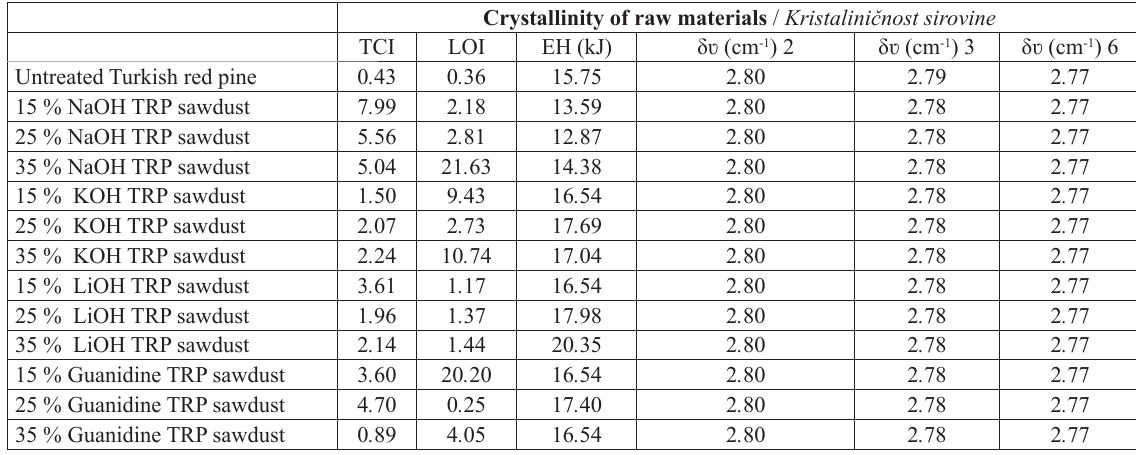
Table 1 Crystallinity of alkaline treated materials of Turkish red pine (TRP)